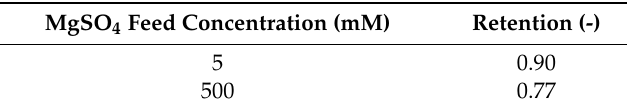
Table 3. Permeability of coated